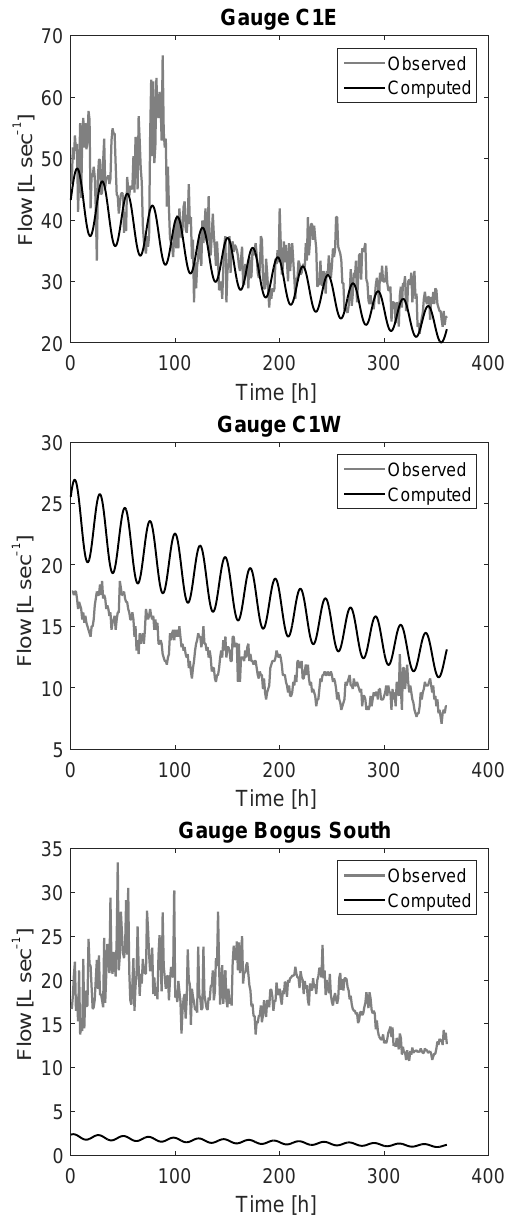
Figure B1. Observed streamflow and streamflow fitted using Eq. (16) at three upstream gauges in the Dry Creek Experimental Watershed: Con1East (top), Con1West (center), and Bogus South